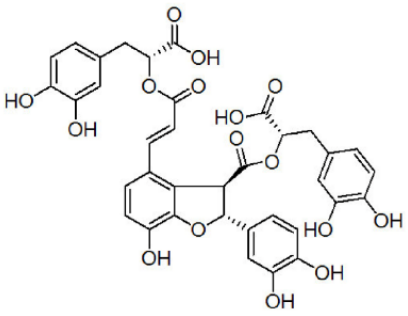
Figure 1. Chemical structure of Salvianolic acid B.